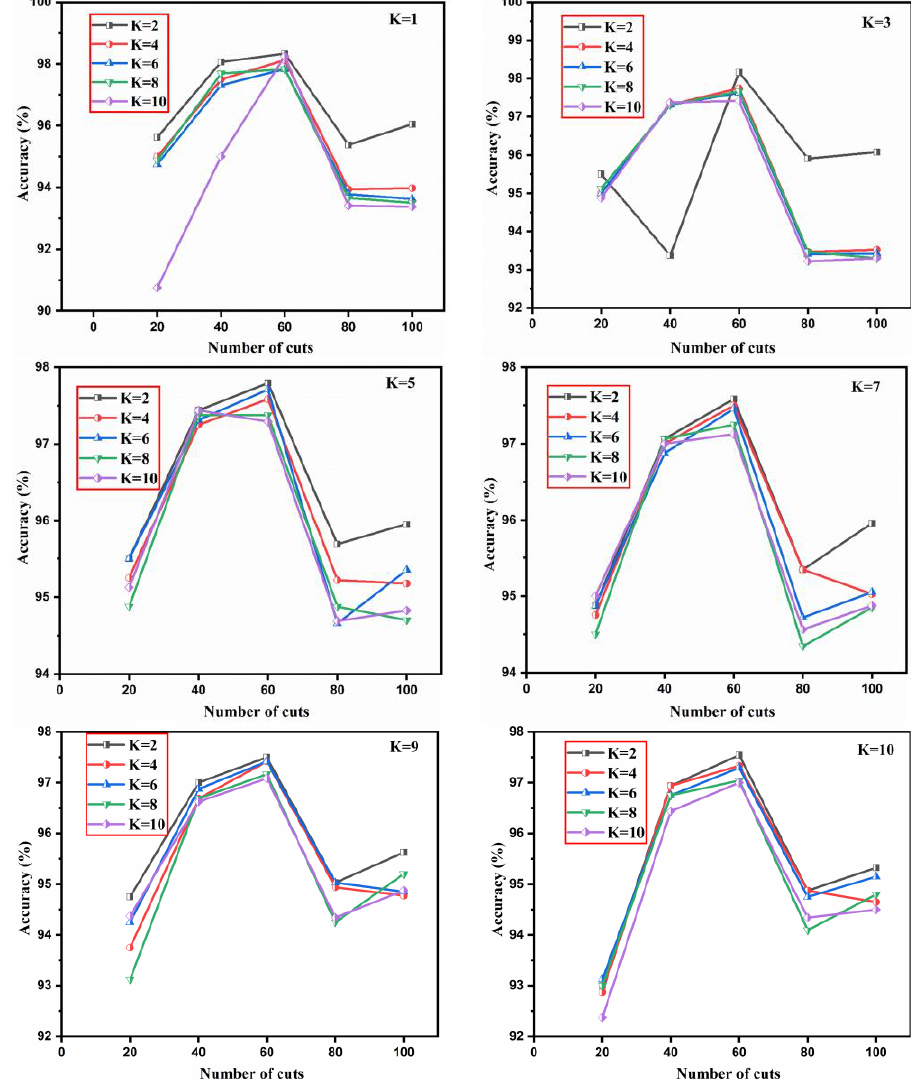
Figure 7. Accuracy percentage achieved with K-mer-based k-NN model with different parameters. Table 2. Best classification performance parameters used for final models and accuracy analysis with and without the subsequence length.